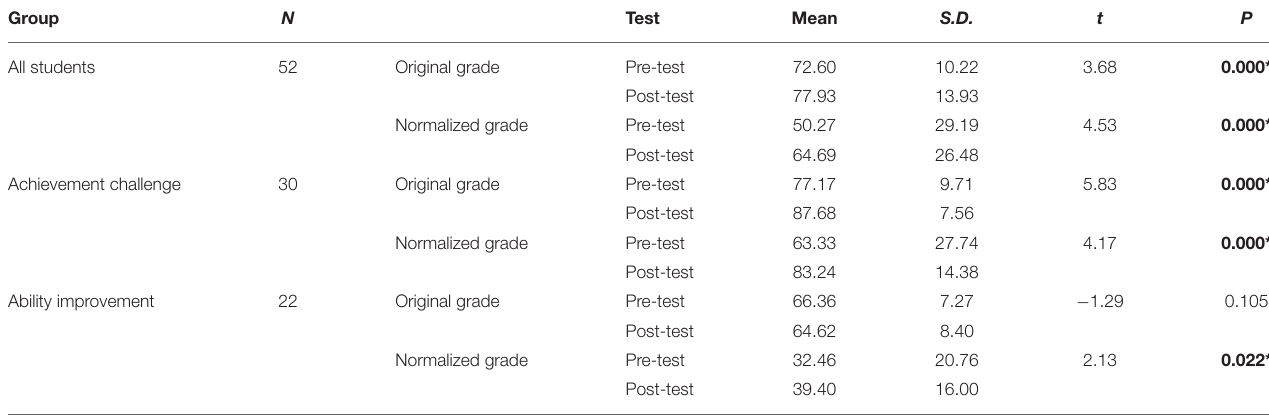
TABLE 1 | Paired t -test result of the grades. Group N